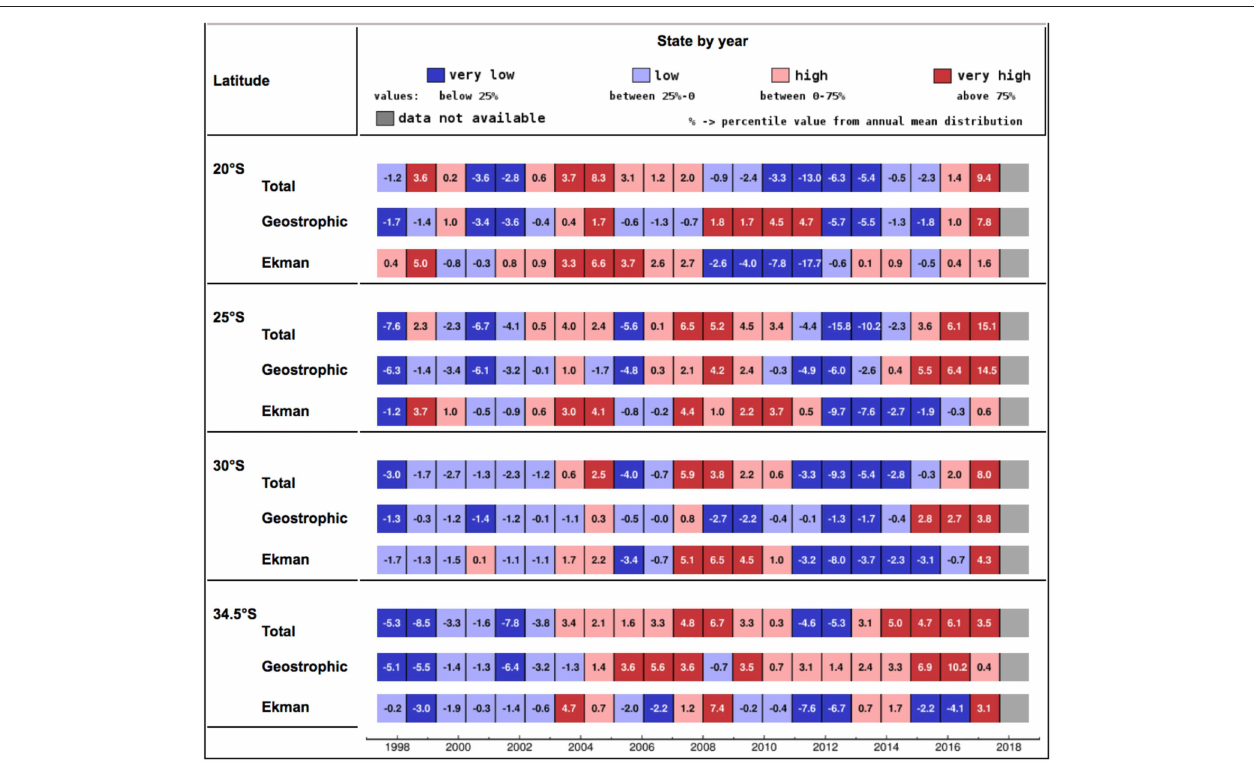
FIGURE 8 | Meridional Heat Transport (MHT) anomalies in the South Atlantic using a combination of XBT, satellite altimetry, and historical hydrographic observations with the red (blue) colors indicating values higher (lower) than the 1993–2017 assessment period average. Values are reported in Petawatts (1 PW = 10 15 watts), and multiplied by 100 for display purposes.